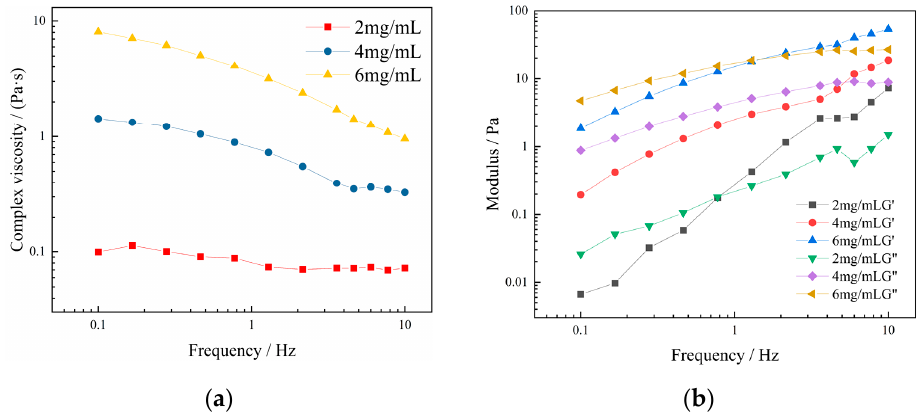
Figure 4. Dynamic viscoelastic curves of KGM with different concentrations: ( a ) relationship between frequency and viscosity; ( b ) relationship between frequency and modulus.